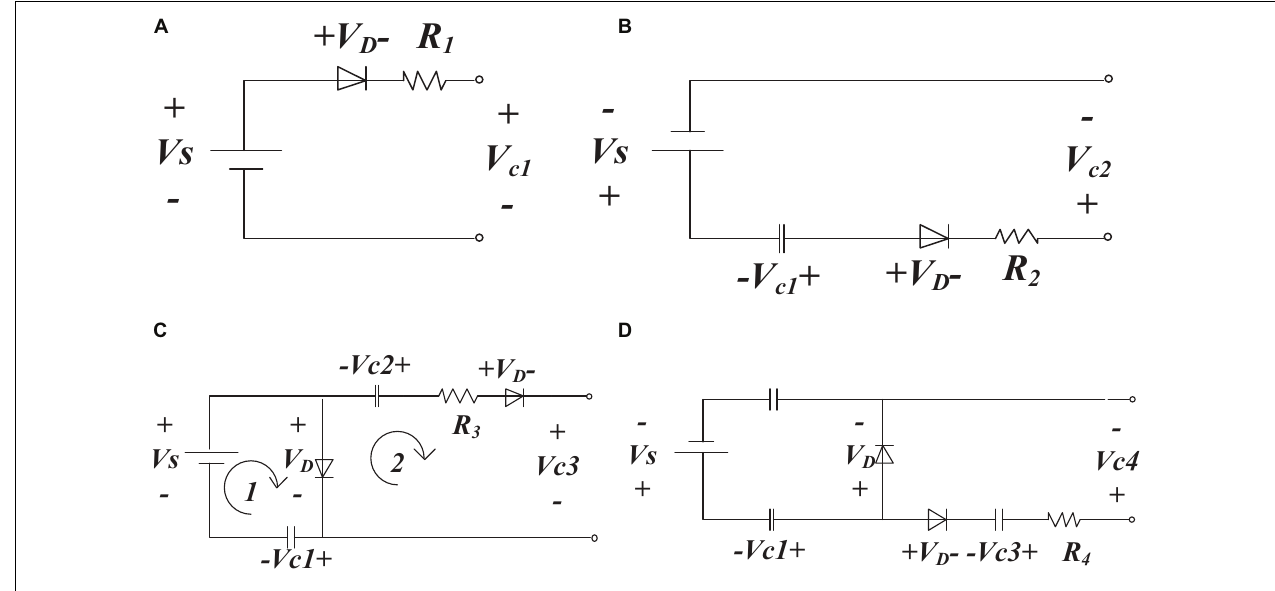
FIGURE 8 | Capacitor charging circuit. (A) Capacitor C 1 charging, (B) capacitor C 2 charging, (C) capacitor C 3 charging, and (D) capacitor C 4